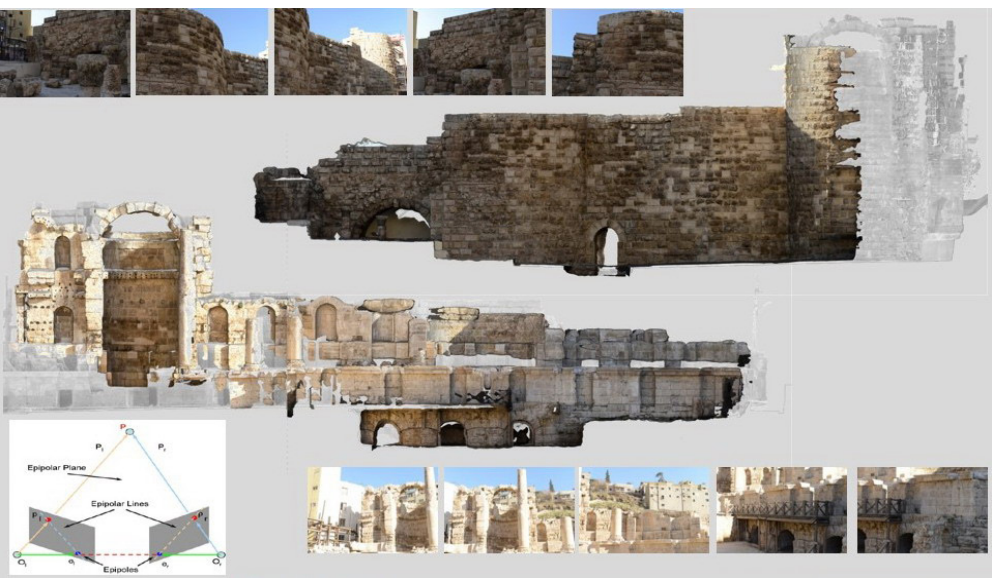
Fig. 11 Bianchini C., Amman Nymphaeum, 3D texturized point cloud from